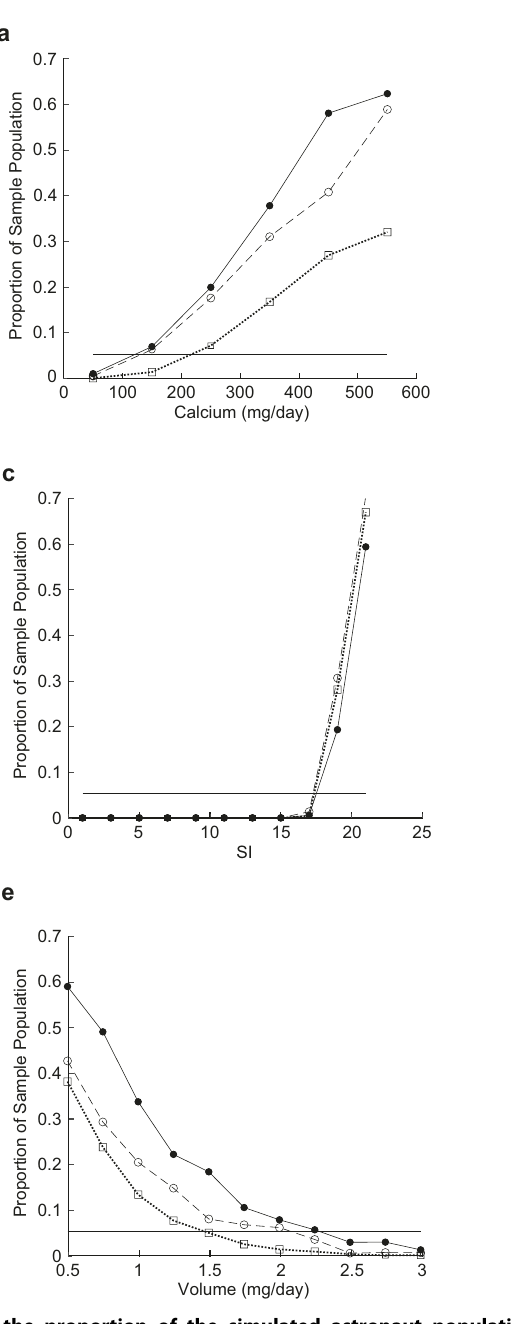
Fig. 6 Plots of the proportion of the simulated astronaut population with IRR ≥ 1.2 with respect to 24-h urine levels. Each fi gure demonstrates the population proportion with IRR > 1.2 when evaluated independently for a calcium, b oxalate, c SI, d citrate, and e 24-h volume levels used in the in- fl ight, post- fl ight and pre- fl ight simulations. Points on each curve represent the midpoint of each bin range: a calcium ± 50 mg/day, b oxalate ± 10 mg/day, c SI ± 1, d citrate ± 100 mg/day, and e volume ± 0.125 L/day. These bin sizes ensure at least 100 simulated results reside in each datapoint to maintain a representation of the other stone formation factors. It is to be noted that the pre- fl ight IRR ≥ 1.2 population proportion level is illustrated by the solid horizontal line on each